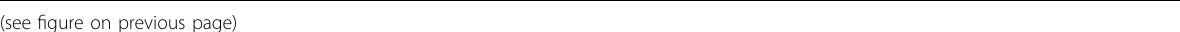
Fig. 1 CRISPR/Cas9 mediated site-speci fi c chromosome breaks and Chr15-17 fusion in haESCs. a Schematic showing the experimental strategy for generating site-speci fi c chromosome fusion of Chr15 (red) and Chr17 (green) in haESCs. Two sgRNAs guide Cas9 (scissors) to the indicated target sites (yellow) located near D-telomere region (gray) of Chr15 and C-telomere region (blue) of Chr17, respectively. Chromosome fusion occurred between two target sites and was detected by cross-chromosomal PCR. Chr15 without D-telomere and Chr17 without C-telomere are ligated through NHEJ pathway, generating Chr15-17 fusion. Primers are designed at the upstream and downstream of each sgRNA target site. b PCR analysis of 25A haESCs with primers mentioned in ( a ). Cross-chromosomal PCR with primer pairs ‘ F1 ’ and ‘ R2 ’ ampli fi ed a ~ 650 bp band only in 25A, while “ F1 ” and “ R1 ” on Chr15 and “ F2 ” and “ R2 ” on Chr17 ampli fi ed a ~700 bp and a ~580 bp band, respectively only in WT but not in 25A. c Fluorescent images of the metaphase chromosomes of WT and 25A haESCs labeled with whole painting probes of Chr15 (red) and Chr17 (green). Insets zoomed-in showing the Chr15 and Chr17 in WT and the fused Chr15-17 in 25A. The mini-chromosome is indicated with a white arrowhead. Scale bar: 10 μ m. d Proliferation rates examined by total cell number of WT and 25A haESCs. ns not signi fi cant. e Real-time PCR analysis of the expression levels of pluripotency marker genes ( Oct4 , Sox2 and Nanog ) and differentiation-related genes (Ectoderm: Pax6, Nestin ; Mesoderm: KDR, α SMA, PDGFR α ; Endoderm: AFP, Gata4, Gata6 ) in differentiated WT and 25A cells. The expression levels were Log transformed. Data are represented as the mean ± SD, n = 3. Gene expression levels were not signi fi cant between WT and 25A cells. f Paraf fi n sections of teratomas formed by WT and 25A cells were stained with three germ-layer markers including the ectoderm marker Tuj1, the mesoderm marker α SMA and the endoderm marker AFP. Scale bar: 20 μ